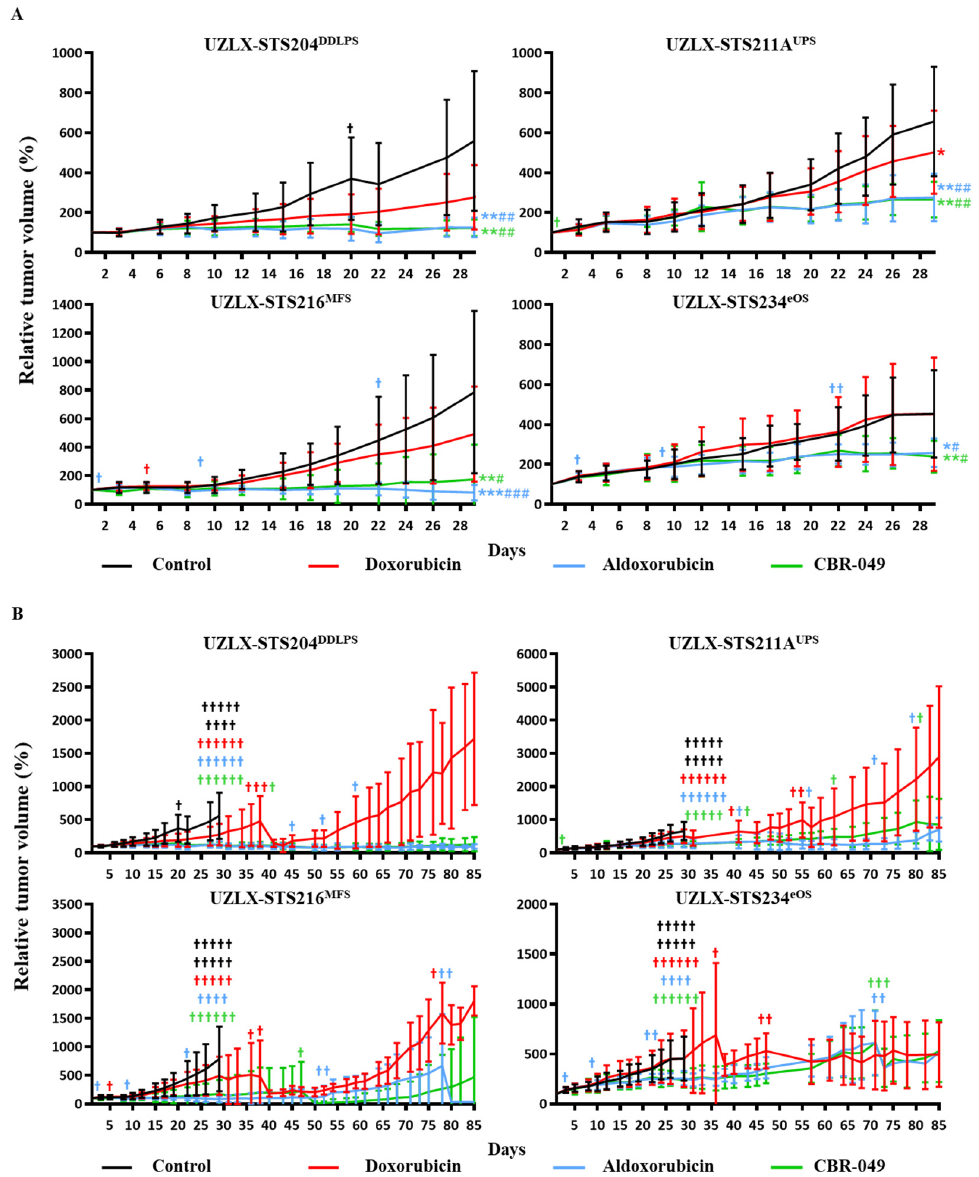
Figure 4. Relative tumor volume (%) compared to baseline in the patient-derived sarcoma xenografts, presented as average ± standard deviation. ( A ) Graphs until day 29 (short-term experiment); ( B ) graphs until day 85 (long-term experiment). Statistical significance was calculated using Mann– Whitney U test. #†: number of mice sacrificed during the experiment. * p < 0.05 compared to control; # p < 0.05 compared to doxorubicin (doxo); ** p < 0.005 compared to control; ## p < 0.005 compared to doxo; *** p < 0.0005 compared to control; ### p < 0.0005 compared to